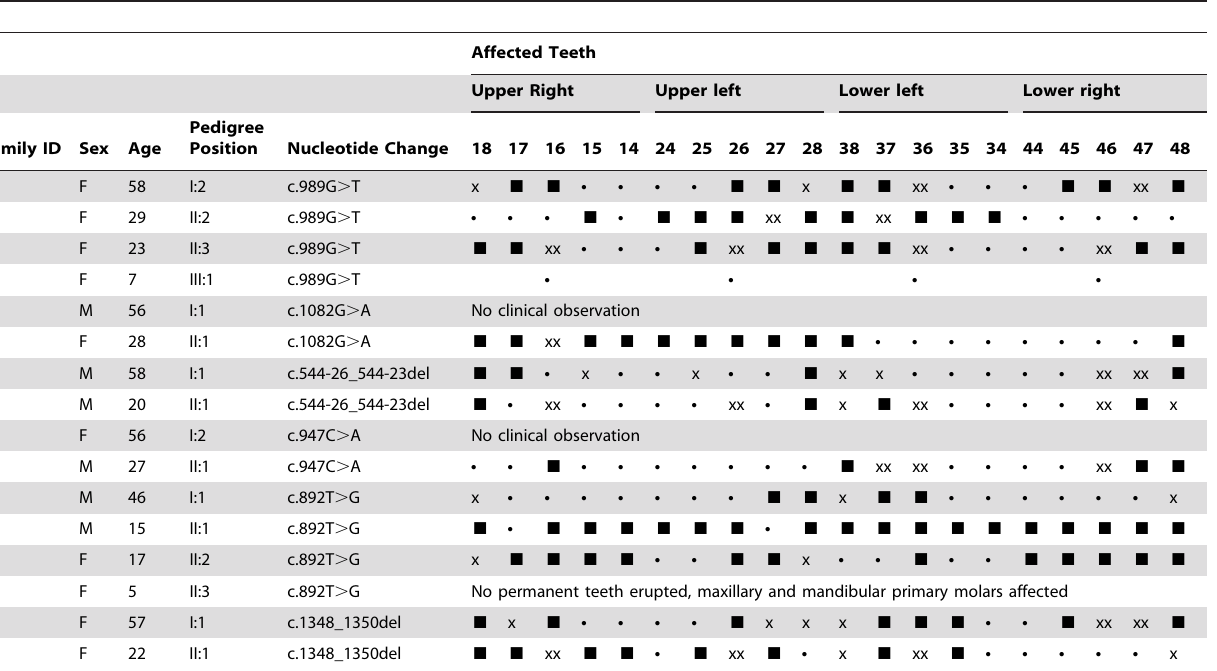
Table 1. Characterization of Family Members with PTH1R Mutations.